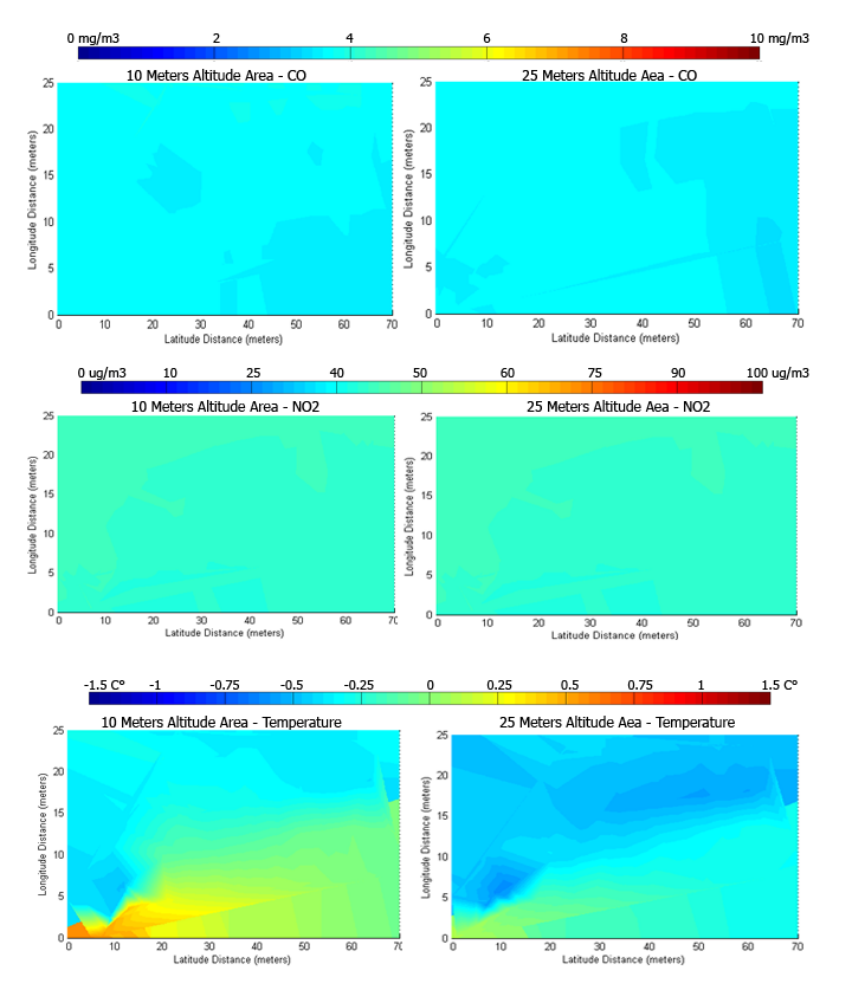
Figure 11. Heat-maps representing changes in gaseous concentrations and temperature for the mission conducted in the winter at the university campus.